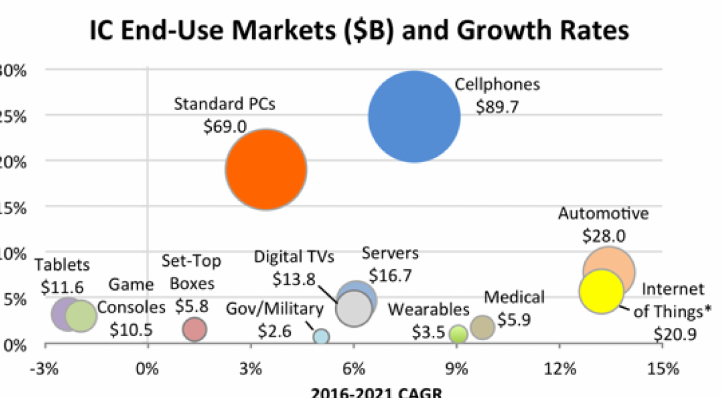
Figure 1. Consumer device growth rates over last five years. * covers only Internet connection portion of the